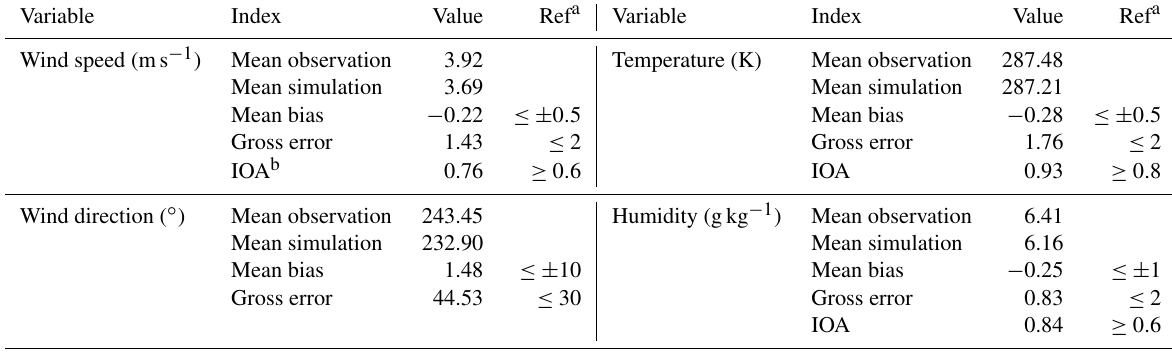
Table 3. Evaluation of meteorological simulation results compared to observational data from the National Climatic Data Center.